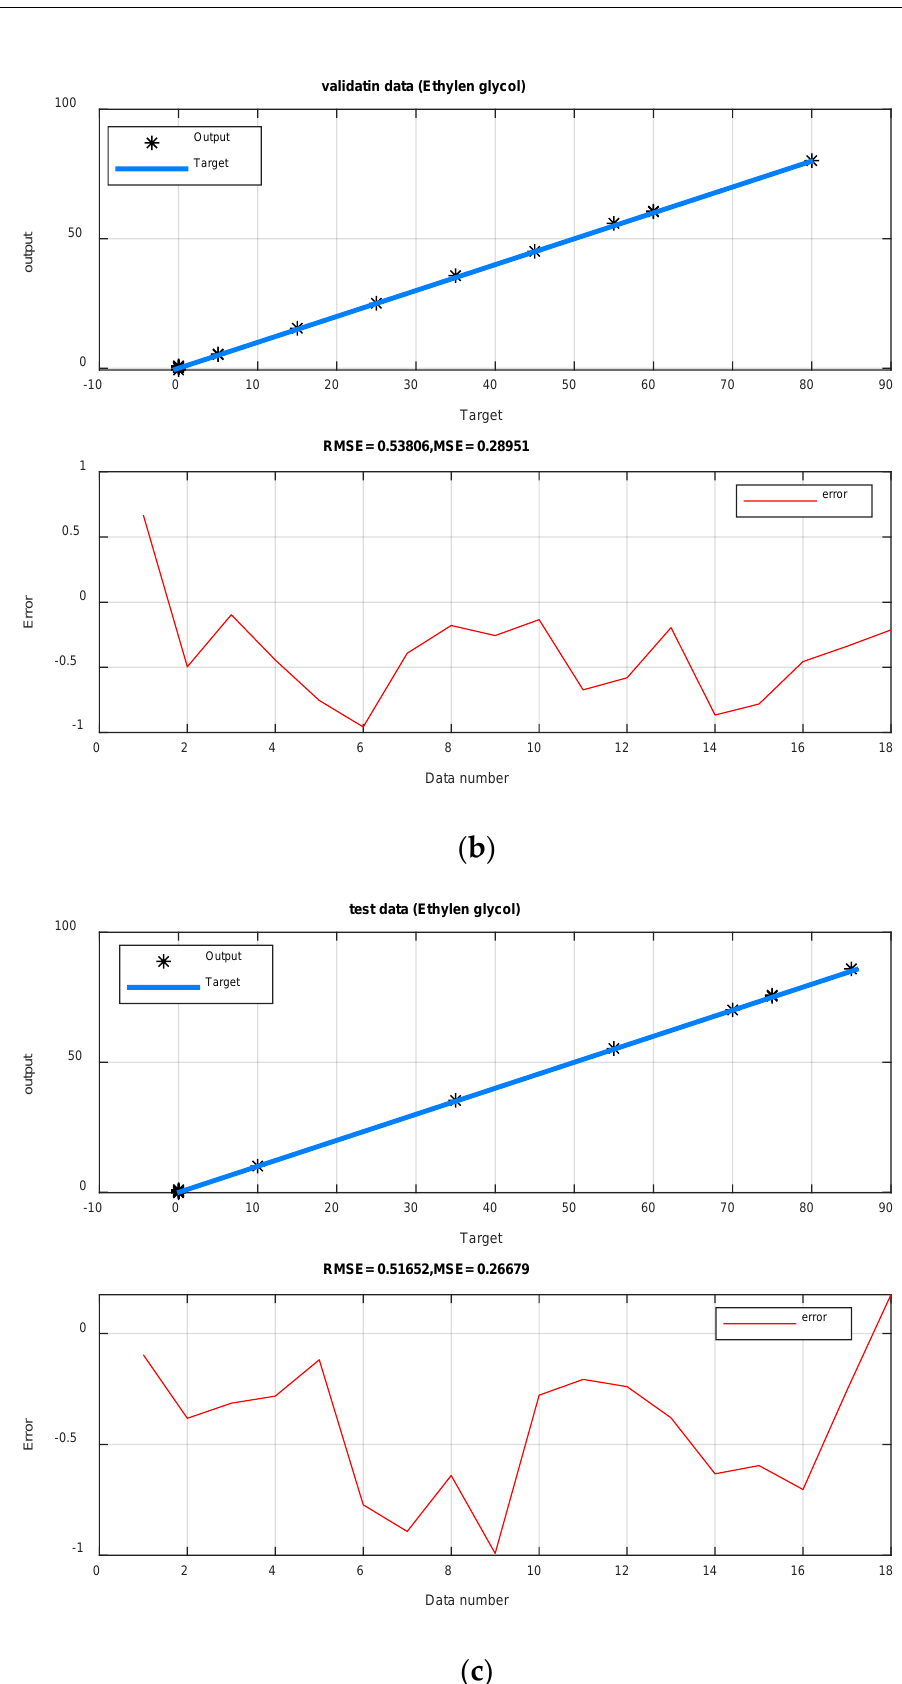
Figure 5. Network performance for predicting the volume rate of ethylene glycol ( a ) Training, ( b ) validation, and ( c ) testing dataset.